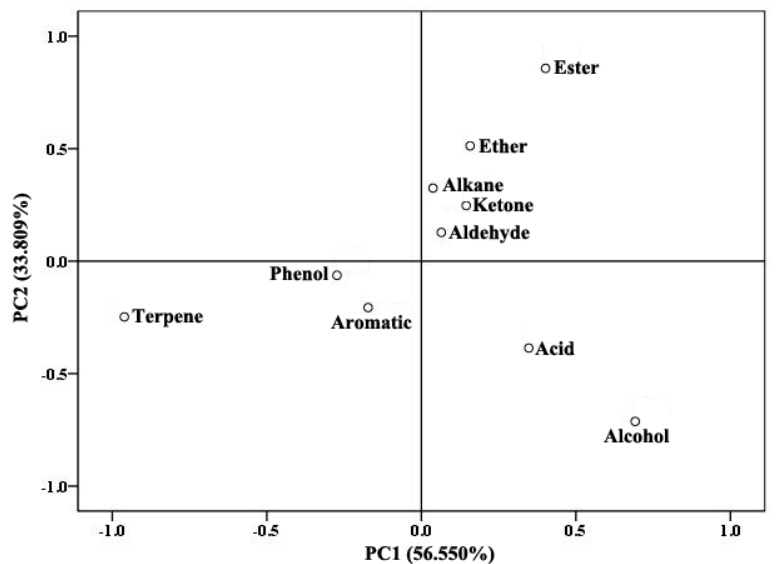
Figure 2. 2D loading plot of eigenvector load values for 10 floral scent component categories from PC1 and PC2.